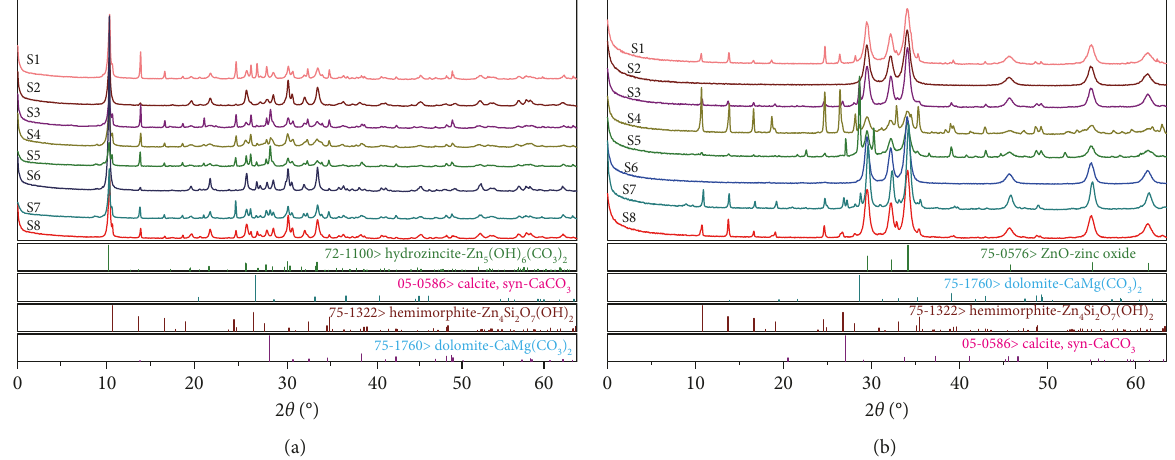
Figure 1: XRD patterns of 8 batches of calamine samples before and after calcination for 100